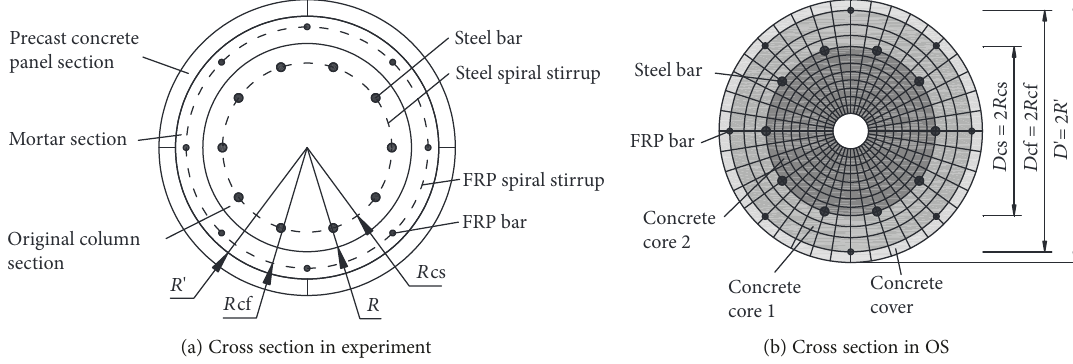
Figure 2: Cross section of the strengthened